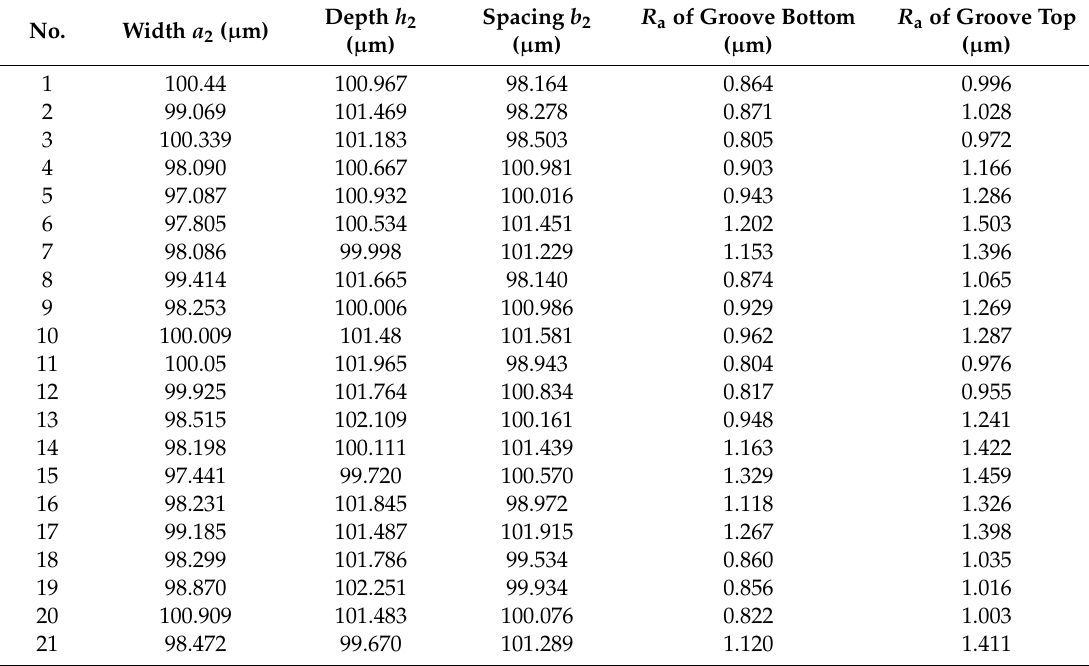
Table 3. The surface roughness and groove size parameters of micro-structured polymer